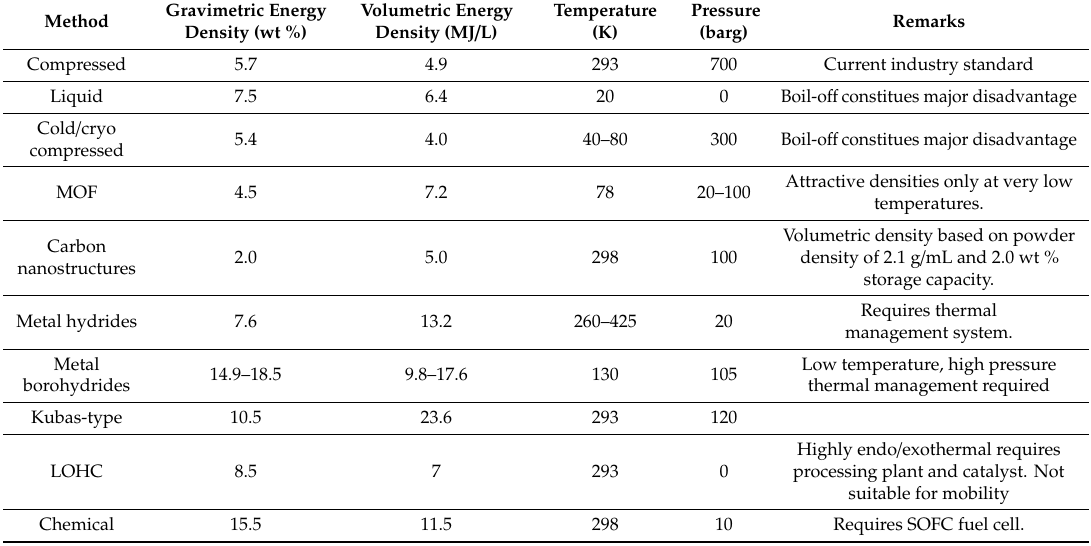
Table 4. Storage methods overview.